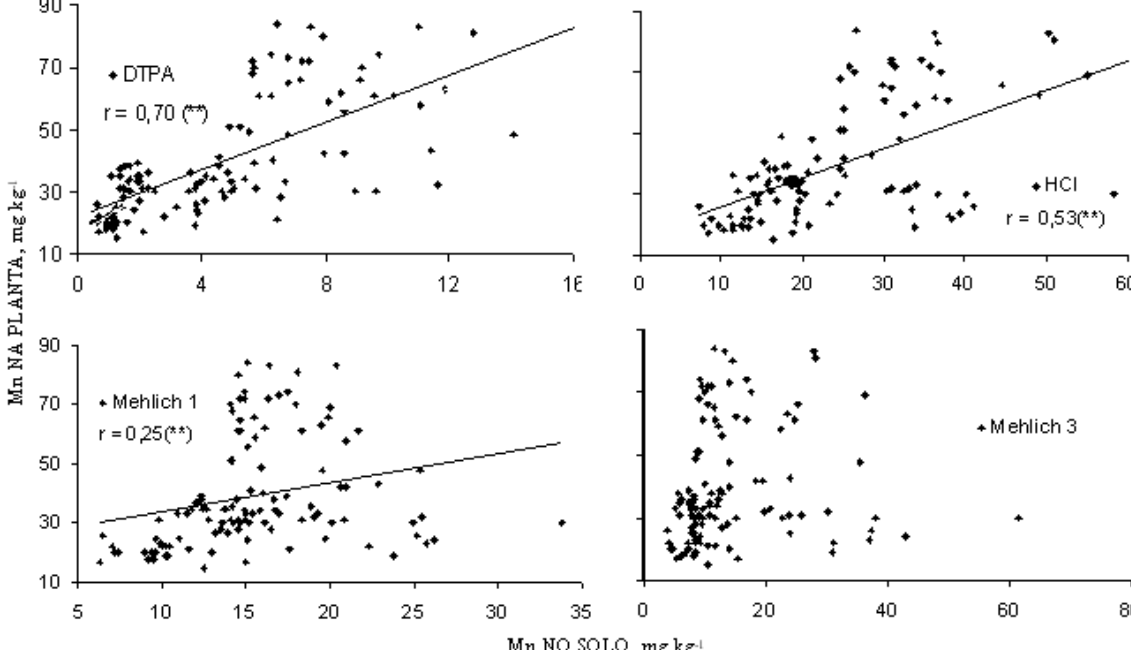
Figura 8. Correlações entre os teores de manganês do solo, extraídos por diversos extratores, após três meses da aplicação ao solo com a concentração de manganês na parte aérea. ns = não-significativo, * e ** significativo a 1 e 5